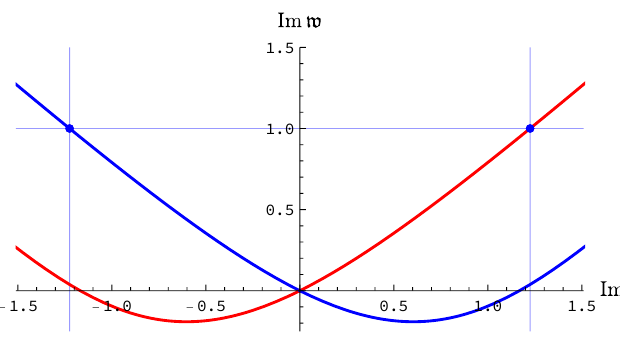
Figure 2 . The analytically continued sound mode frequencies in the strongly coupled N = 4 SYM theory, obtained using the dual holographic description. The dimensionless frequencies w (cid:6) the two sound modes are plotted for purely imaginary dimensionless spatial momentum q , with the \+" branch in red and the \ (cid:0) " branch in blue. The frequencies w (cid:6) imaginary q . At small momenta, the curves are linear with slopes (cid:6) v s , with v s = 1 = pass through pole-skipping points ( q (cid:3) ; w (cid:3) ) = ( (cid:6) i